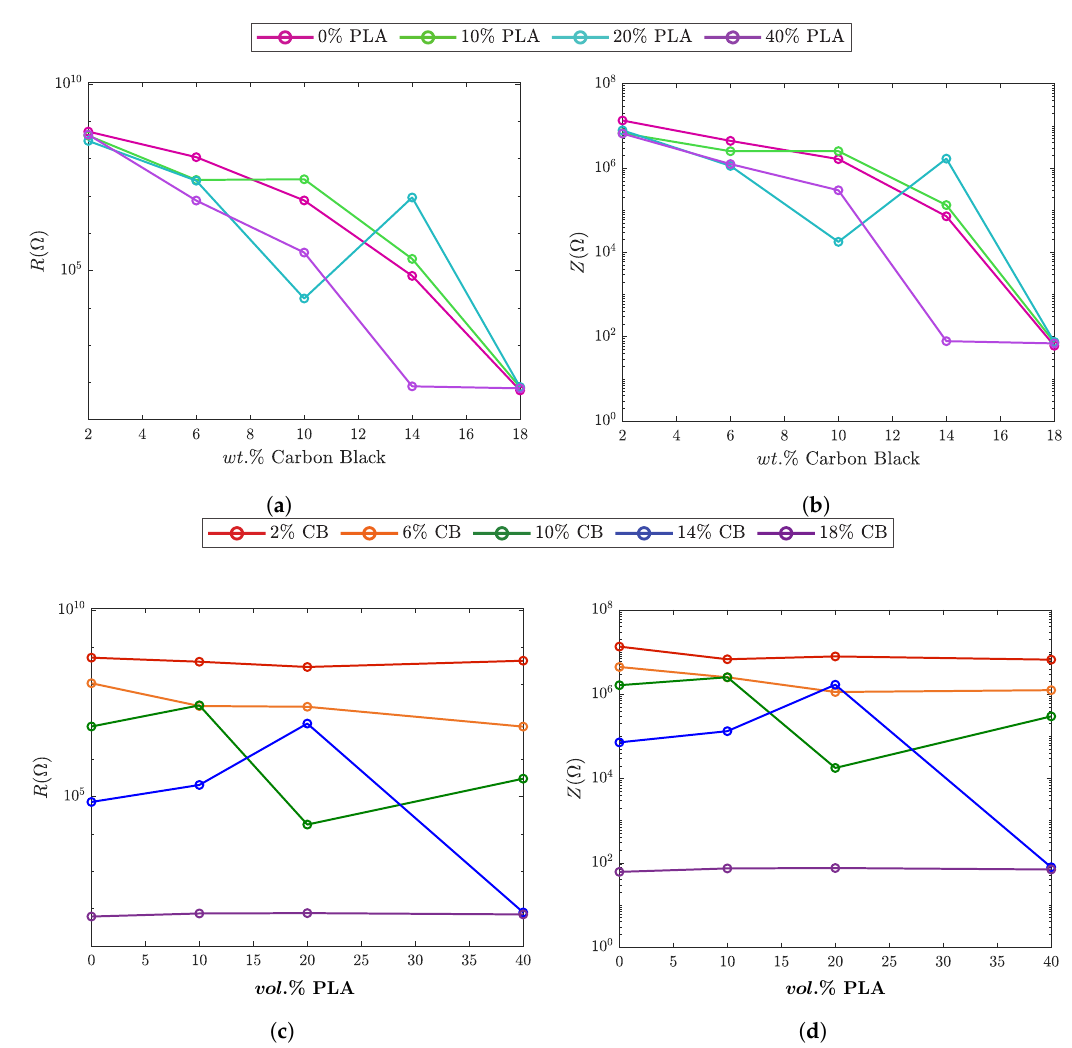
Figure 3. Four point impedance spectroscopy of PHBV:PLA blends with increasing CB nanofiller percentages at 10 3 Hz: ( a ) Resistance versus CB%, ( b ) impedance versus CB%, ( c ) resistance versus PLA fraction, and ( d ) impedance versus PLA